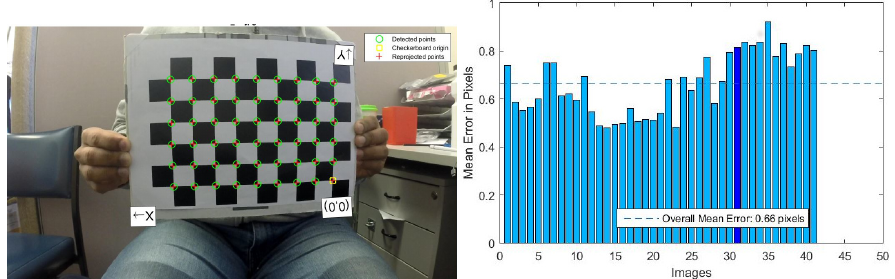
Figure 12. Figure showing detected and re-projected corner points after camera calibration ( left ) and mean re-projection error in the pixel coordinates of all images used during camera calibration ( right ).